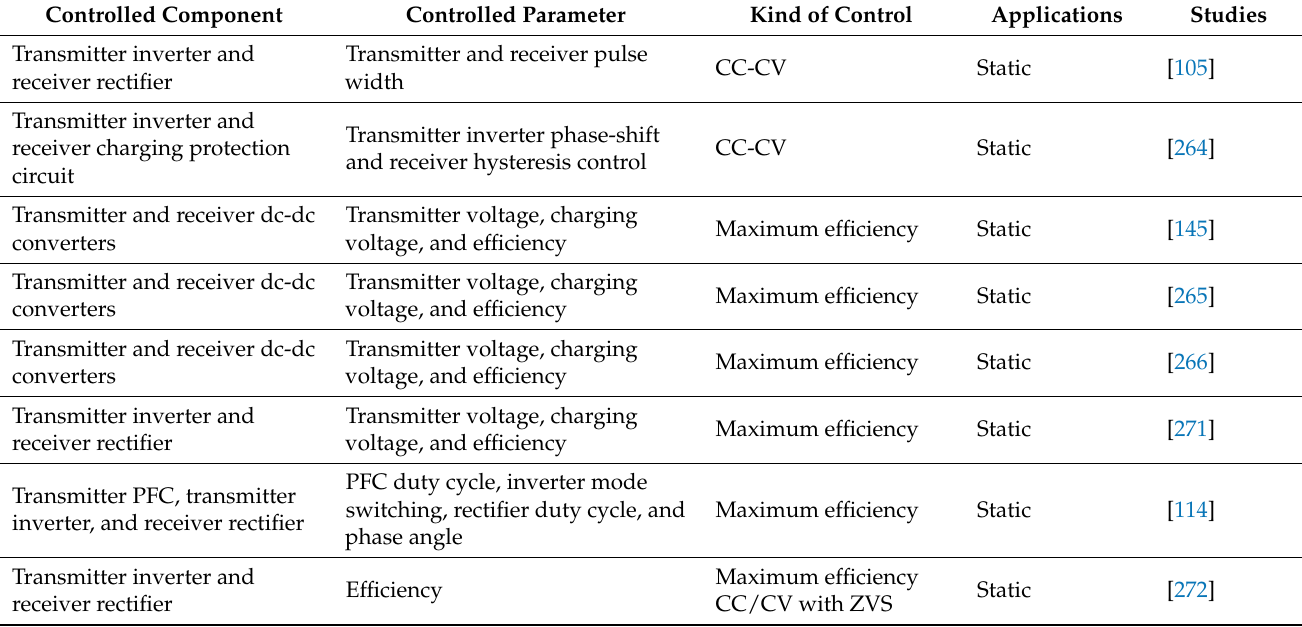
Table 13. Various dual-side control techniques.